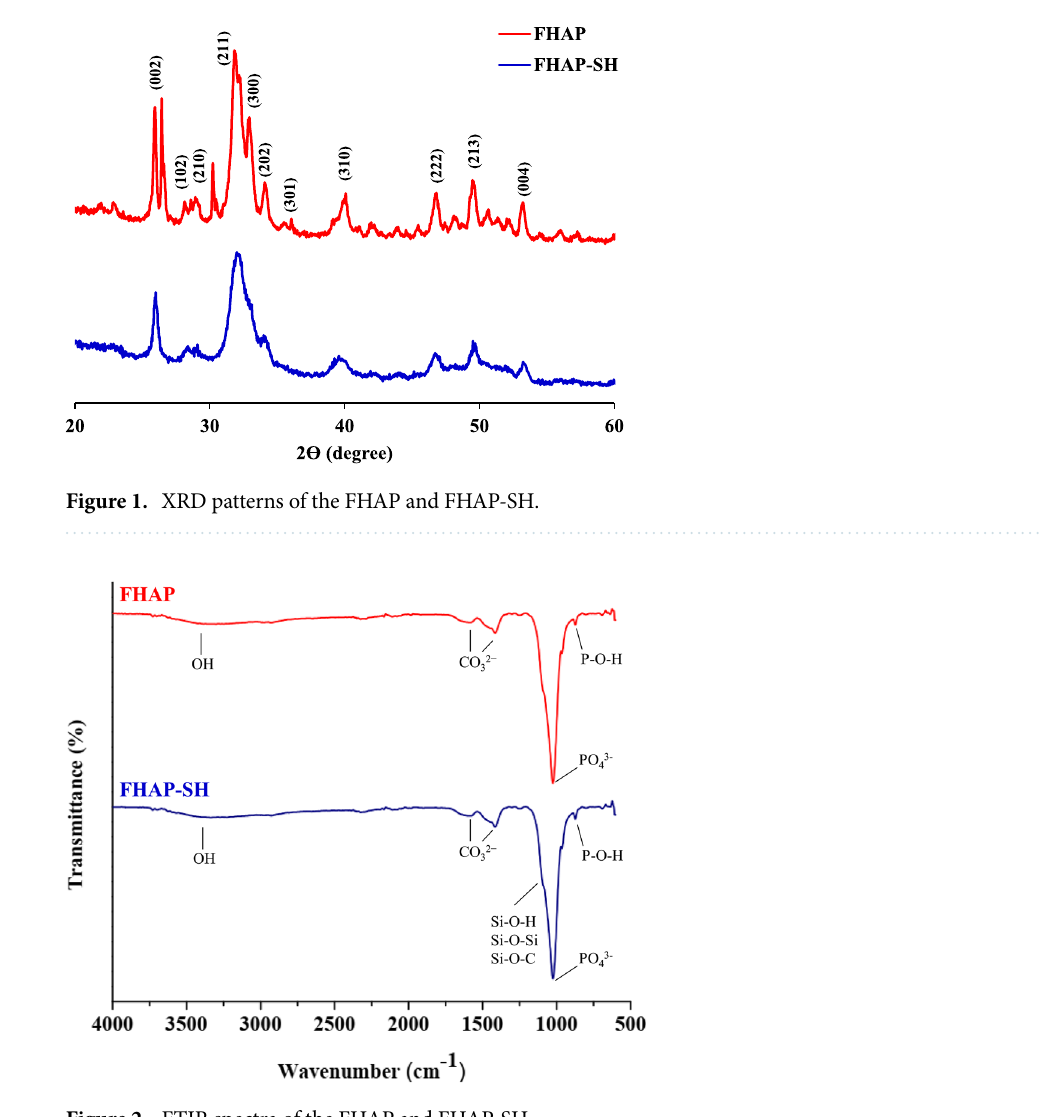
Figure 2. FTIR spectra of the FHAP and